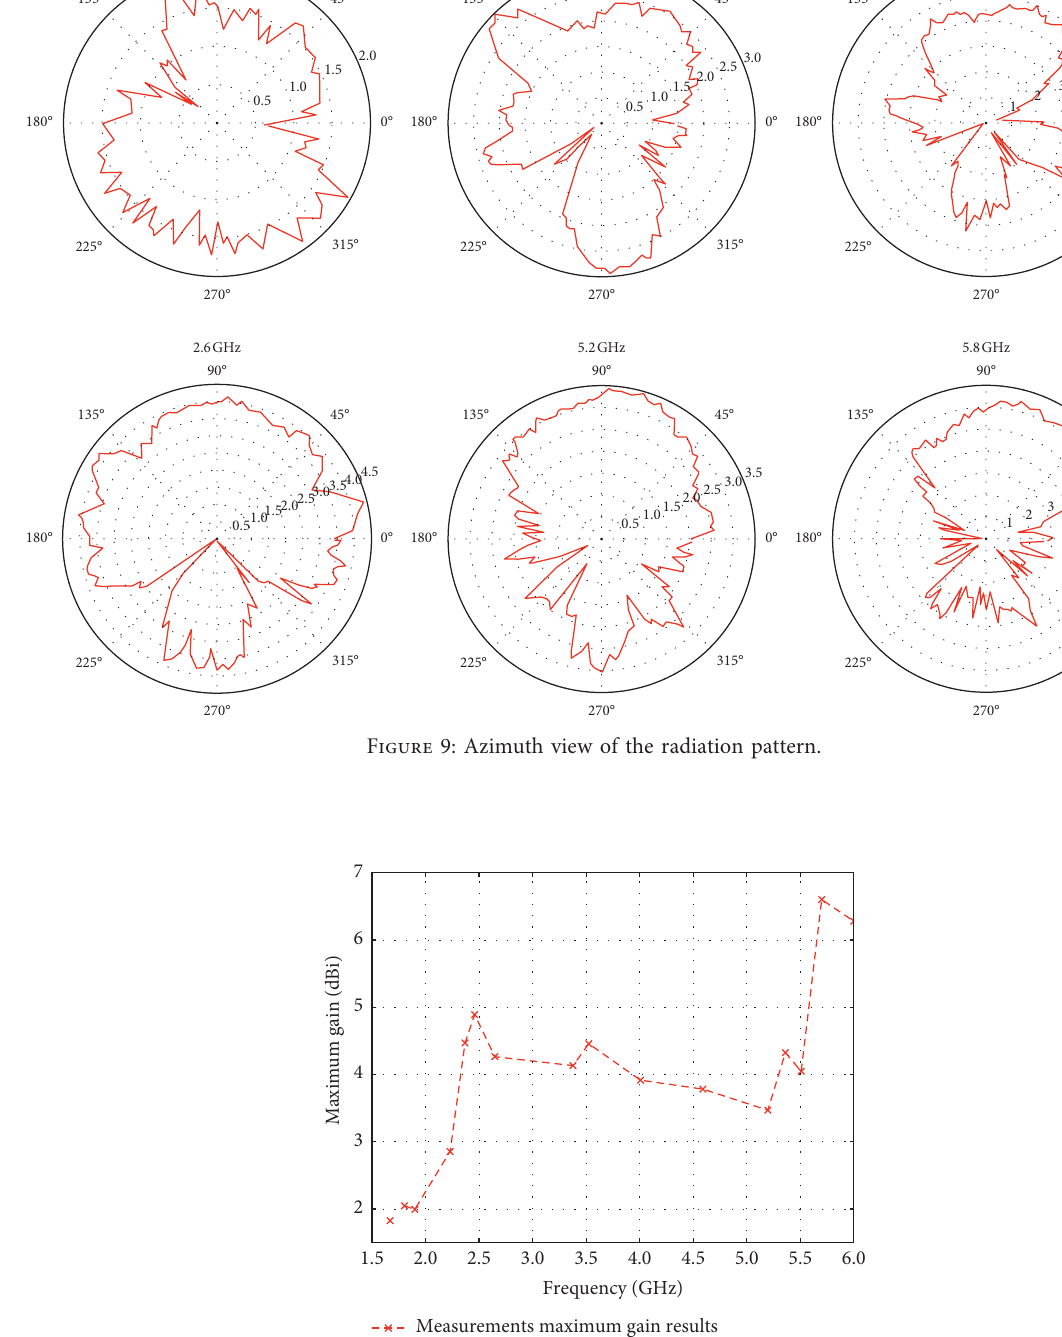
Figure 10: Variation of the maximum gain over